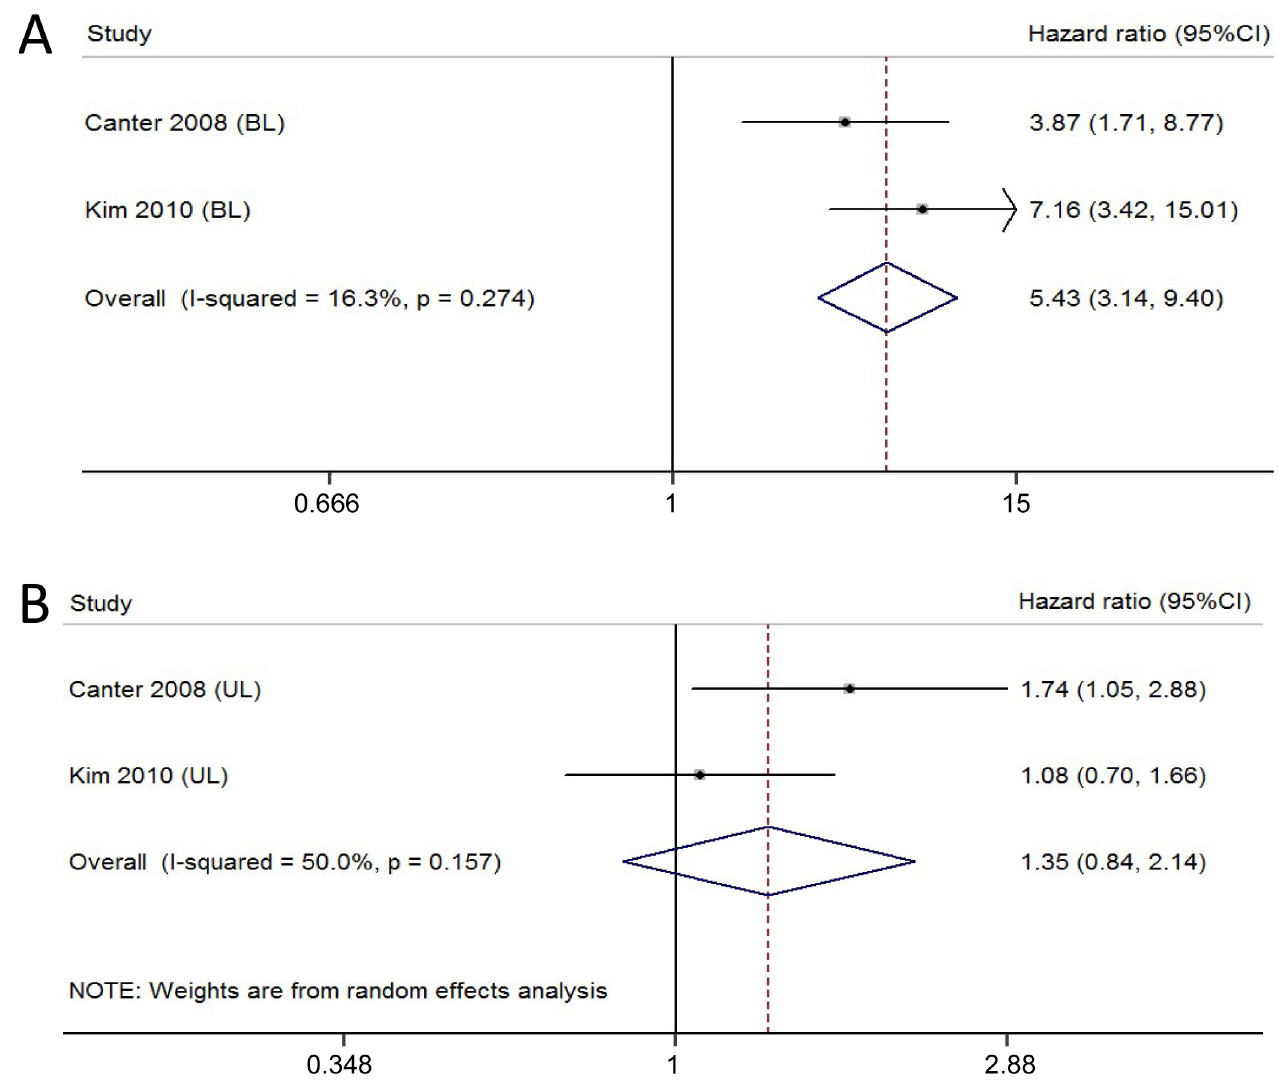
Fig 4. Forest plots showing the association between bilateral or unilateral hydronephrosis and CSS in bladder cancer patients. (A) Bilateral hydronephrosis (BL); (B) Unilateral hydronephrosis (UL).